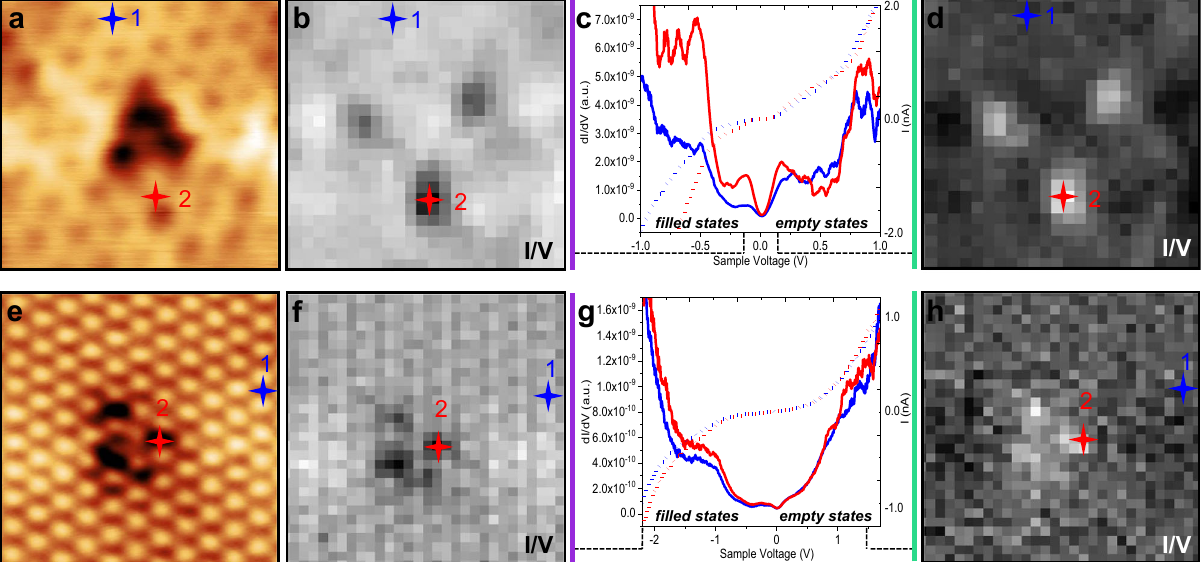
Fig. 3 Grid spectroscopy of PtTe 2 type C and E defects. a STM topography of the type C defect (3 × 3 nm 2 , V = 0.6 V and I = 740 pA). Grid spectroscopy was performed on the area in a . b I / V map depicts the tunneling current value (taken from the I ( V )) at each spectroscopy point on the grid (25 × 25 points) at a bias voltage value of − 0.150 V ( fi lled states). Three dark points correspond to lower tunneling current of the defect on the fi lled states in PtTe 2 . c Individual I / V (dotted line) and d I /d V (solid line) spectra of two points indicated by the colored stars in a , b , and d positioned on a fl at terrace and on the defect. d I / V map at + 0.148 V above the Fermi level. e STM topography of the type E defect (4 × 4 nm 2 , V = 0.9 V and I = 250 pA). Grid spectroscopy was performed on the area in e . f I / V map depicts the tunneling current value (taken from the I ( V )) at each spectroscopy point on the grid (30 × 30 points) at a bias voltage value of − 2.2 V. g Individual I / V (dotted line) and d I /d V (solid line) spectra of two points on the grid indicated by the colored stars in e , f , and h positioned on a defect-free terrace and on the defect. h I / V map at + 1.48 V above the Fermi